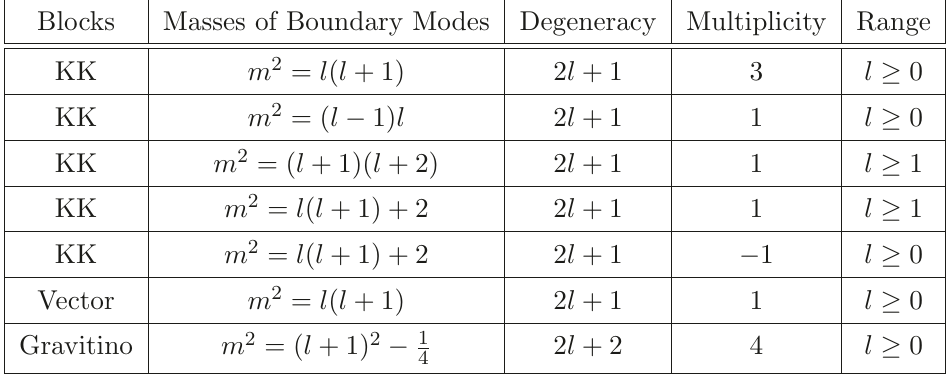
1 denotes contri- −